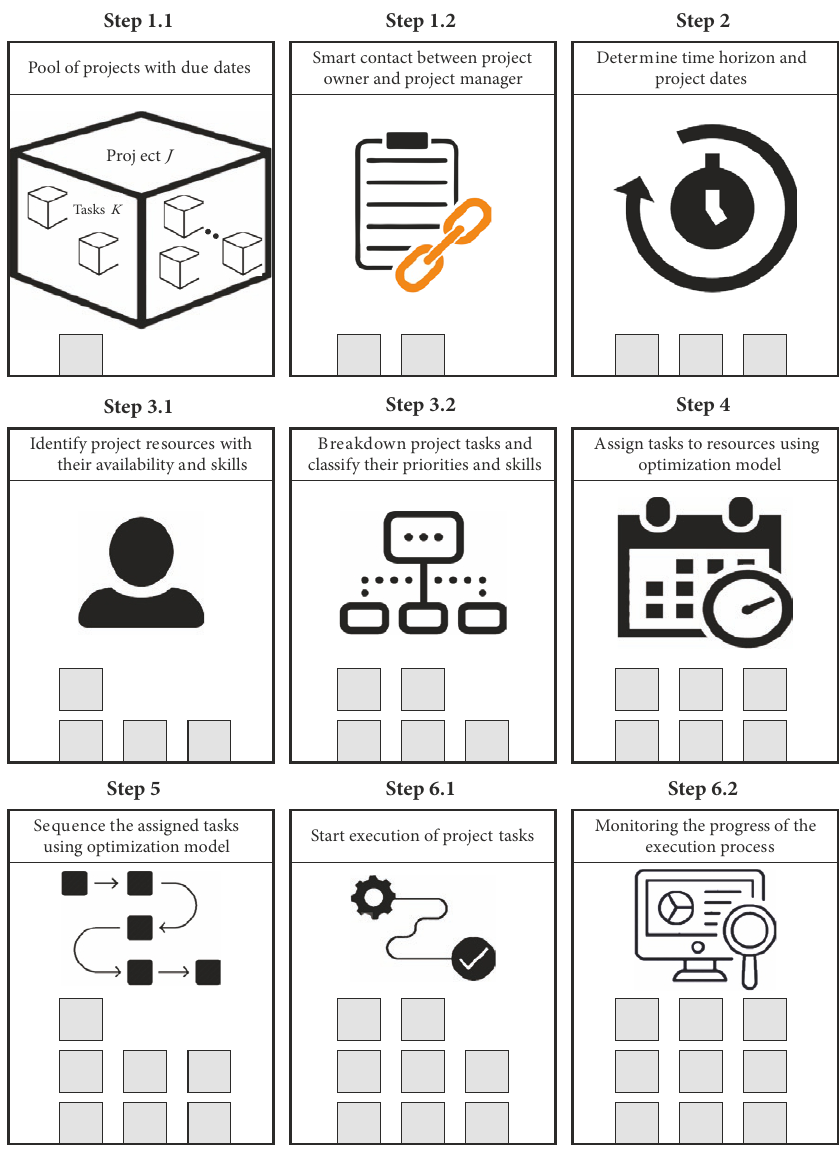
Figure 2. Blockchain implementation in project